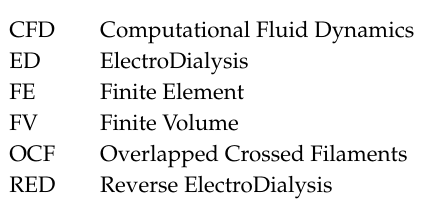
s1. Figure S1. Engineering Stress vs Strain curve of the anion exchange membrane tested immersed in water. The linear elastic region is marked by a dashed line. The stress and strain at break are also highlighted. Figure S2. Experimental setup. (a) Overall layout; (b) Bulge test cell and laser head; (c) Detail of the Plexiglas plates making up the bulge test